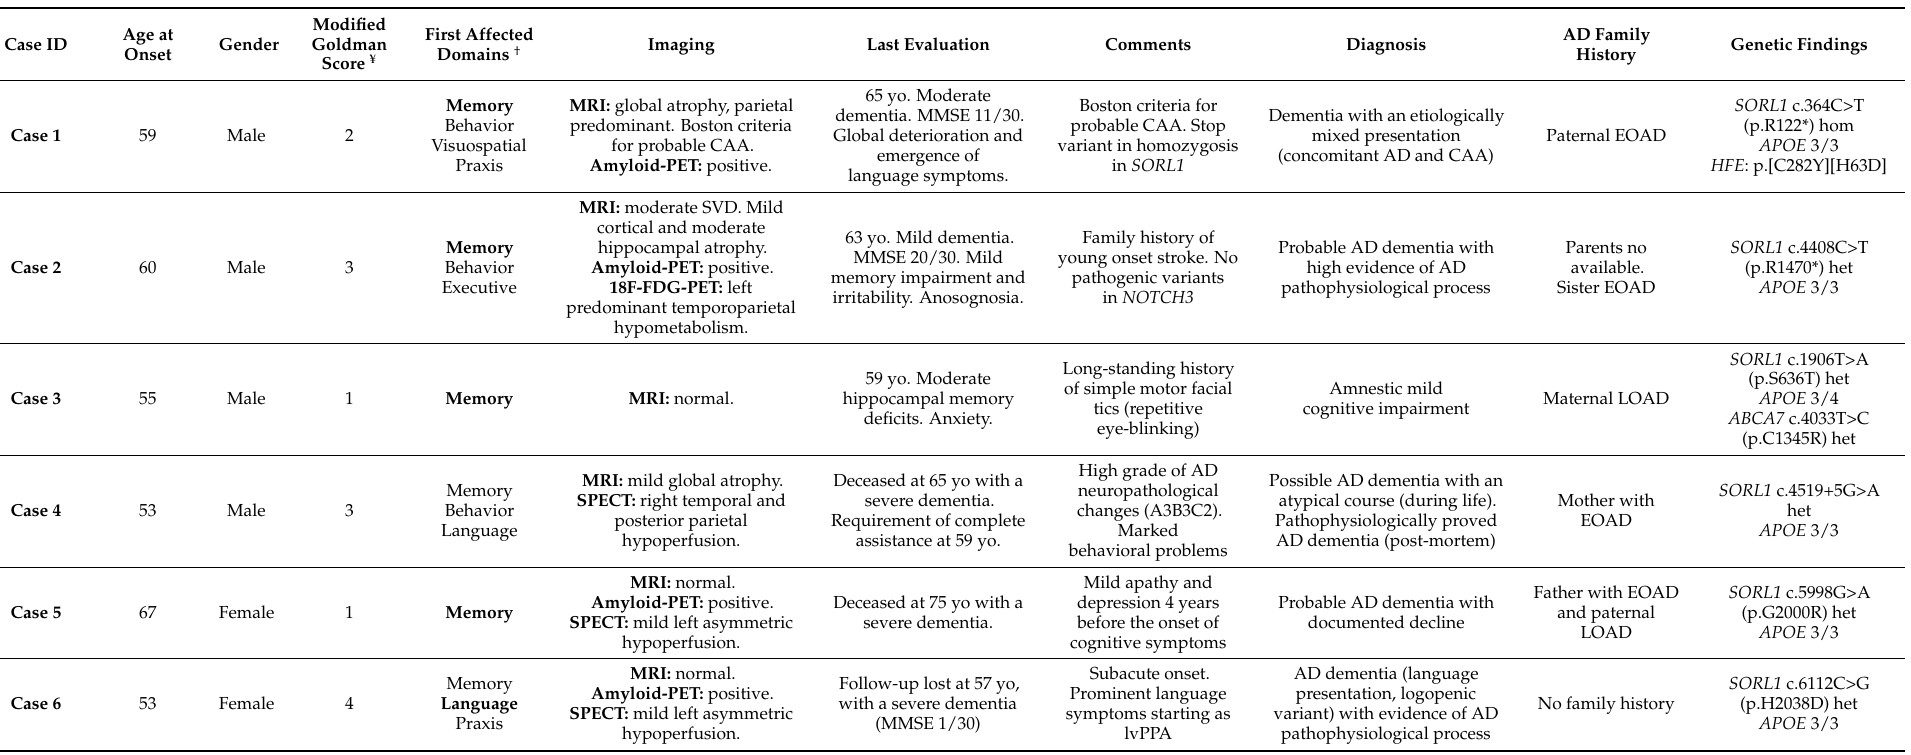
Table 1. Main clinical findings of Alzheimer’s disease patients with variants in the SORL1 (NM_003105.6)